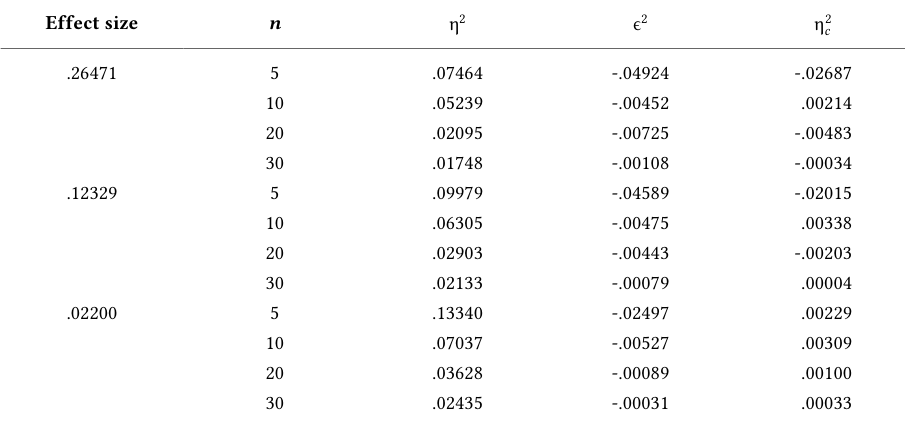
Bias Estimates for η 2 , ϵ 2 , and η c2 Under Normality Effect size n η